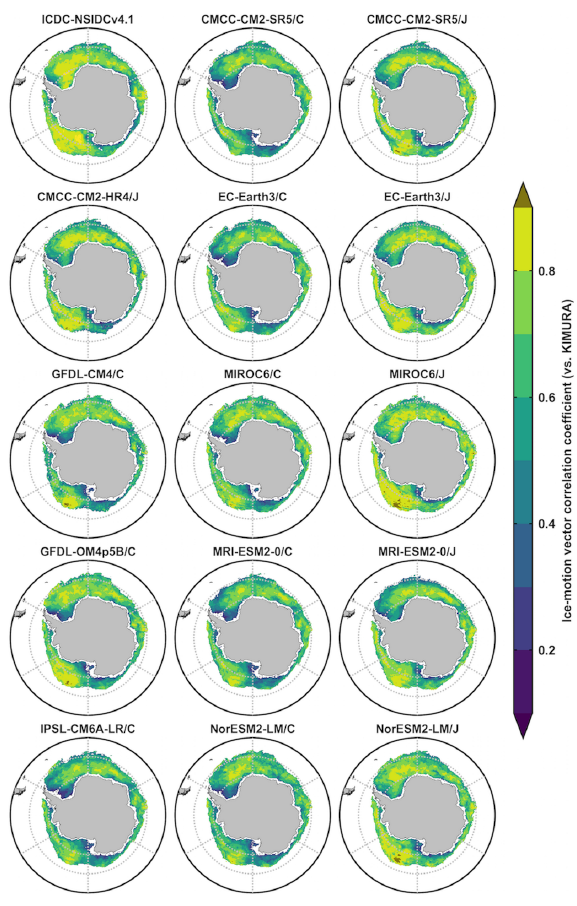
Figure 9. The significant Antarctic ice-motion vector correlation coefficients from monthly mean data during 2003–2007 at a level of 99% between ICDC-NSIDCv4.1/model outputs and the KIMURA data. The second and third columns are from the five OMIP1 and OMIP2 model outputs of CMCC-CM2-SR5, EC-Earth3, MIROC6, MRI-ESM2-0, and NorESM2-LM, respectively.